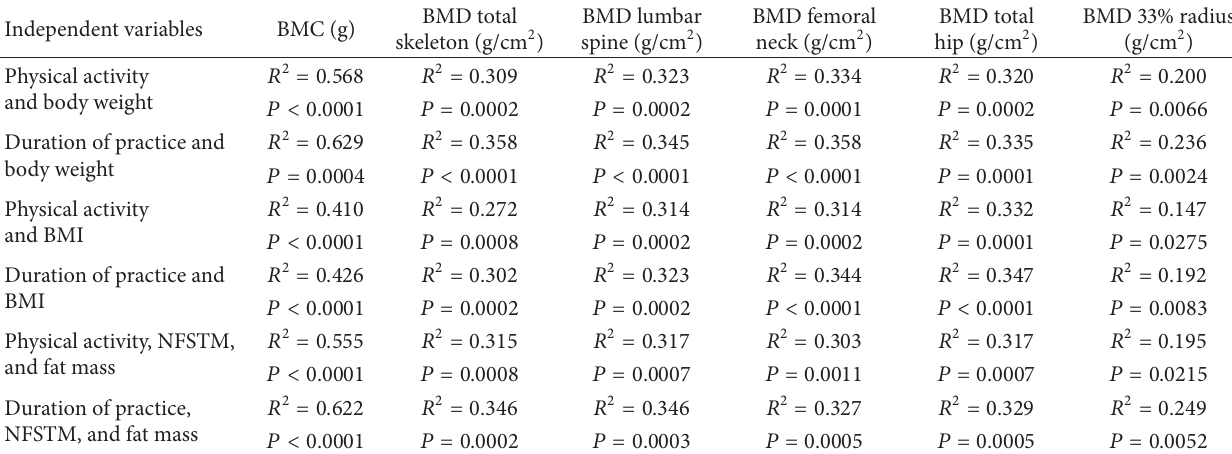
Table 5: Selected multiple regression results for all three groups ( 𝑛 = 48